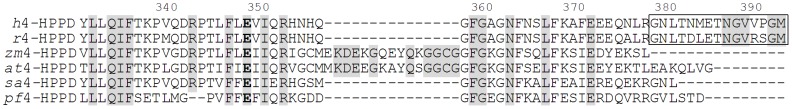
Alignment of amino acid sequences of the C-terminus of human 4-HPPD with enzymes from other species [37].Fully conservative sequences and residues in iron binding sphere are colored grey and dark grey, respectively. Abbreviations used: h4-HPPD, Homo sapiens (human) 4-HPPD; r4-HPPD, Rattus norvegicus (rat) 4-HPPD; zm4-HPPD, Zea mays 4-HPPD; at4-HPPD, Arabidopsis thaliana 4-HPPD; sa4-HPPD, Streptomyces avermitilis 4-HPPD; pf4-HPPD, Pseudomonas fluorescens 4-HPPD. The sequences for the h4-HPPD and r4-HPPD C-terminal tail (G379 to M393) are highlighted by the square frame.